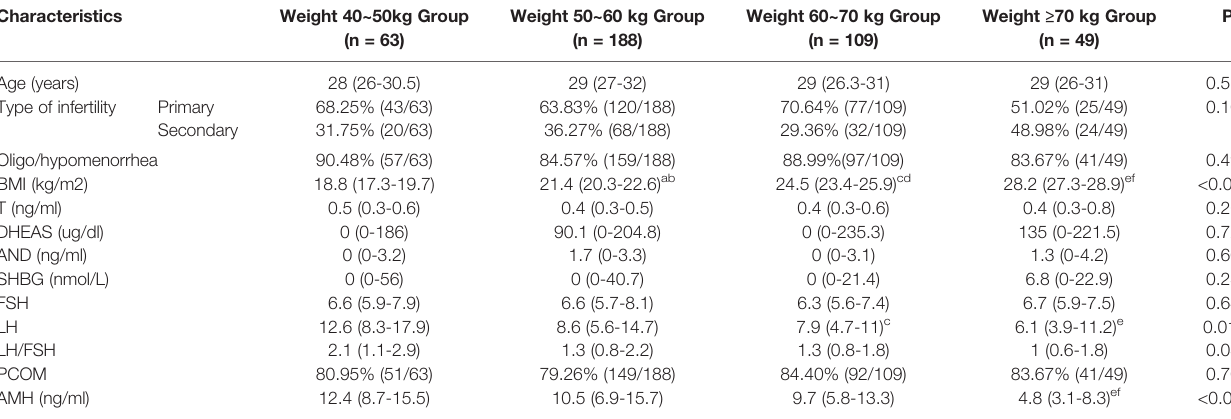
TABLE 1 | Baseline characteristics of PCOS patients in four body weight groups (n = 409). Characteristics